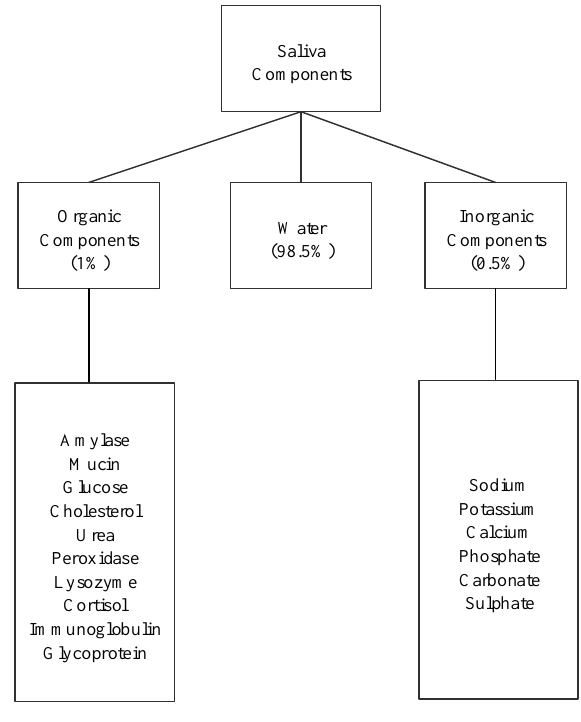
Figure 1. Components of human saliva.